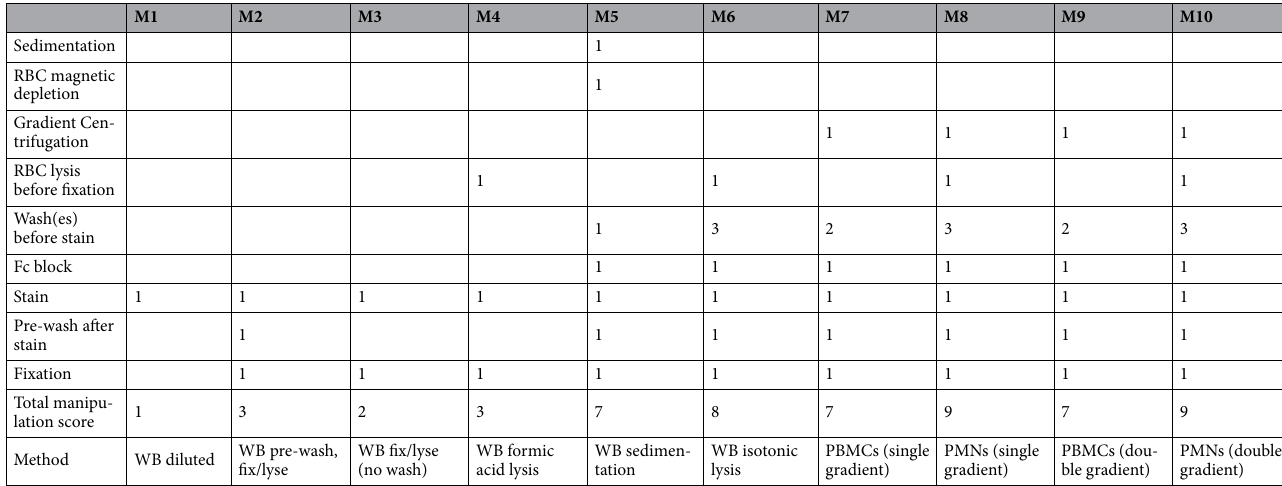
Table 1. Manipulation steps during neutrophil characterization. Summary of the steps performed during neutrophil characterization by each method (M1–M10) quantified as the total number of manipulation steps before